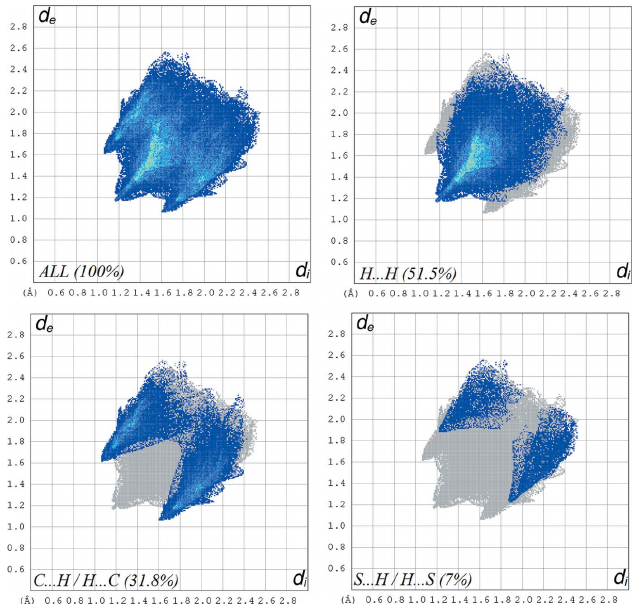
Figure 4 Two-dimensional fingerprint plots, showing the relative contribution of the atom-pair interactions to the Hirshfeld